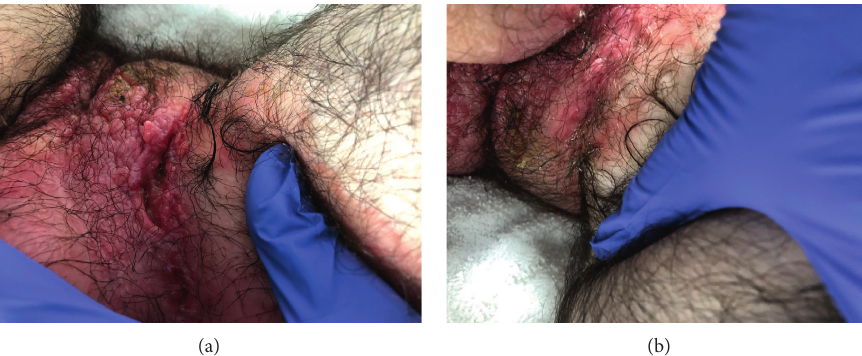
Figure 1: Well-demarcated erythematous plaques, nodules, and papules noted on the groin (a) and gluteal cleft (b) observed prior to treatment with adalimumab.